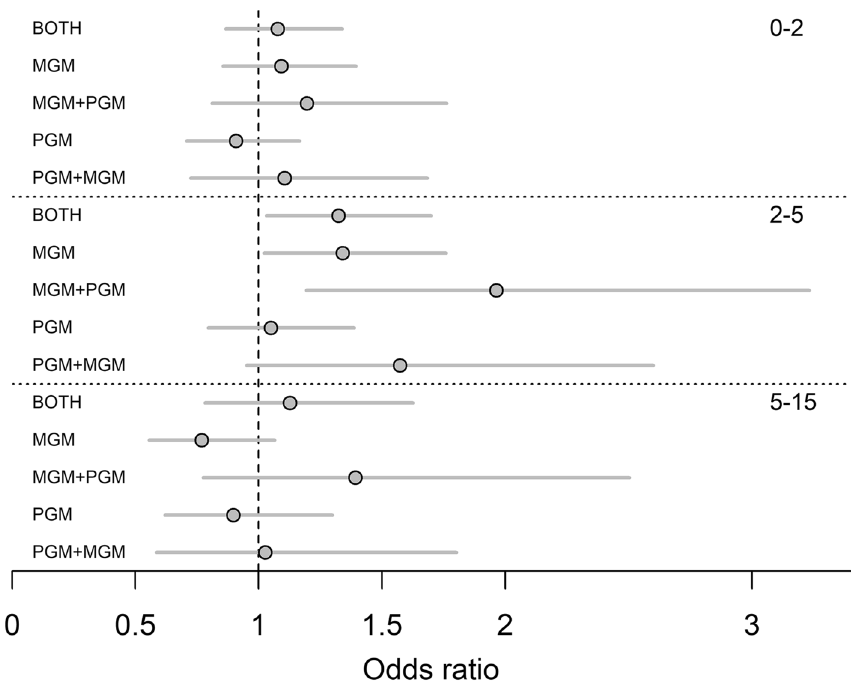
Figure 4. Odds ratios of grandchild survival by grandmother presence and lineage exclusivity of grandmothers. MGM maternal grandmother alive, PGM paternal grandmother alive, MGM + PGM maternal grandmother alive and has living grandchildren through son, PGM + MGM paternal grandmother alive and has living grandchildren through daughter. Lines for each value are 95% confidence intervals. Vertical dashed line indicates an odds ratio of 1; an overlapping odds ratio indicates there is no meaningful difference in survival compared to the baseline of having no living grandmother. All models controlled for mother survival status. Age class 0–2 additionally controlled for sex, whether the focal individual was a twin, social class, and region of Finland, and age class 5–15 controlled for number of living